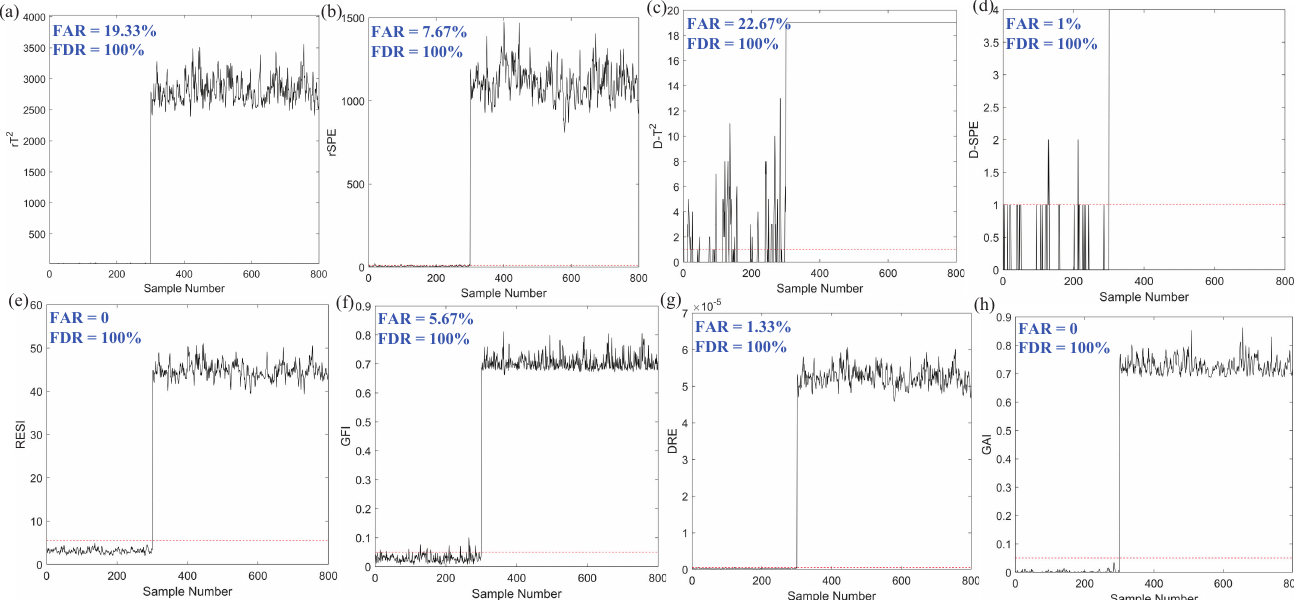
Figure 13. The process monitoring results of anode effect in aluminum electrolysis process. ( a ) rPCA- rT 2 ; ( b ) rPCA- rSPE ; ( c ) DPCA- D − T 2 ; ( d ) DPCA- D − SPE ; ( e ) KSVD- RESI ; ( f ) DDL- GFI ; ( g ) DPL- DRE ; ( h ) DRDPL- GAI .